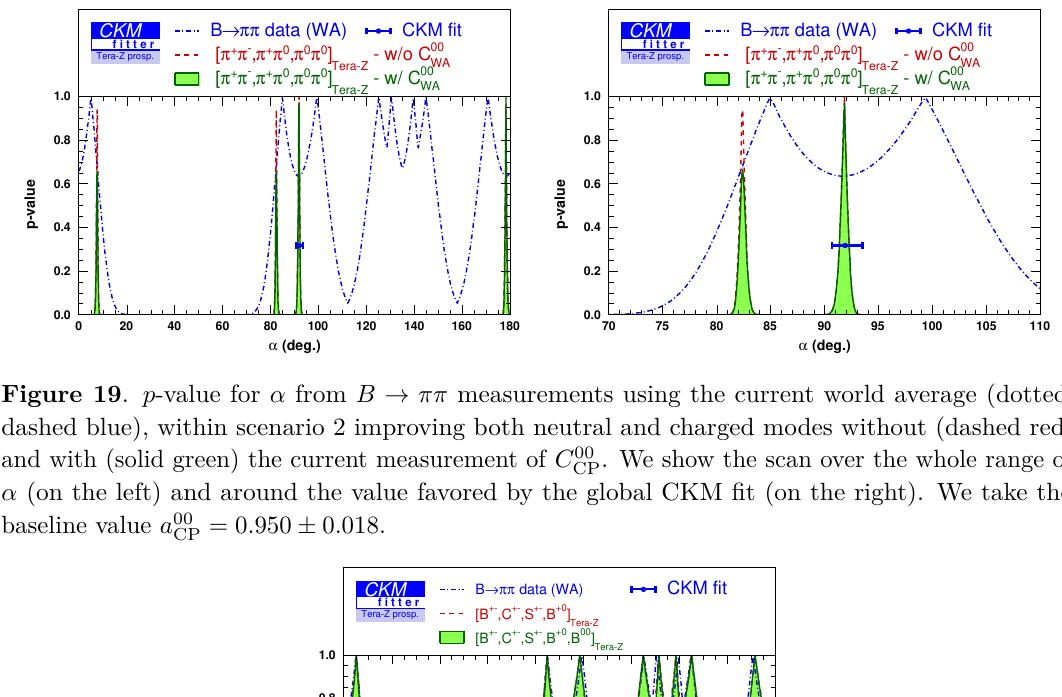
¯ B 0 , B − modes on the right) in = 0 . 950 ± 0 . 018 . CP